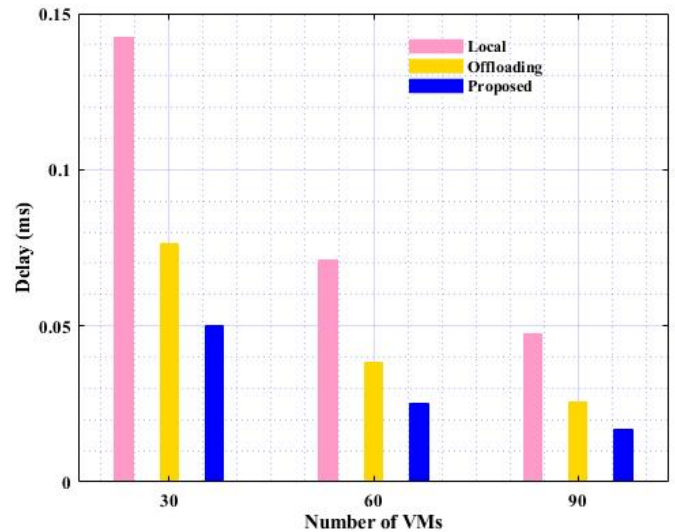
Figure 5. Performance vs. VMs—average delay.